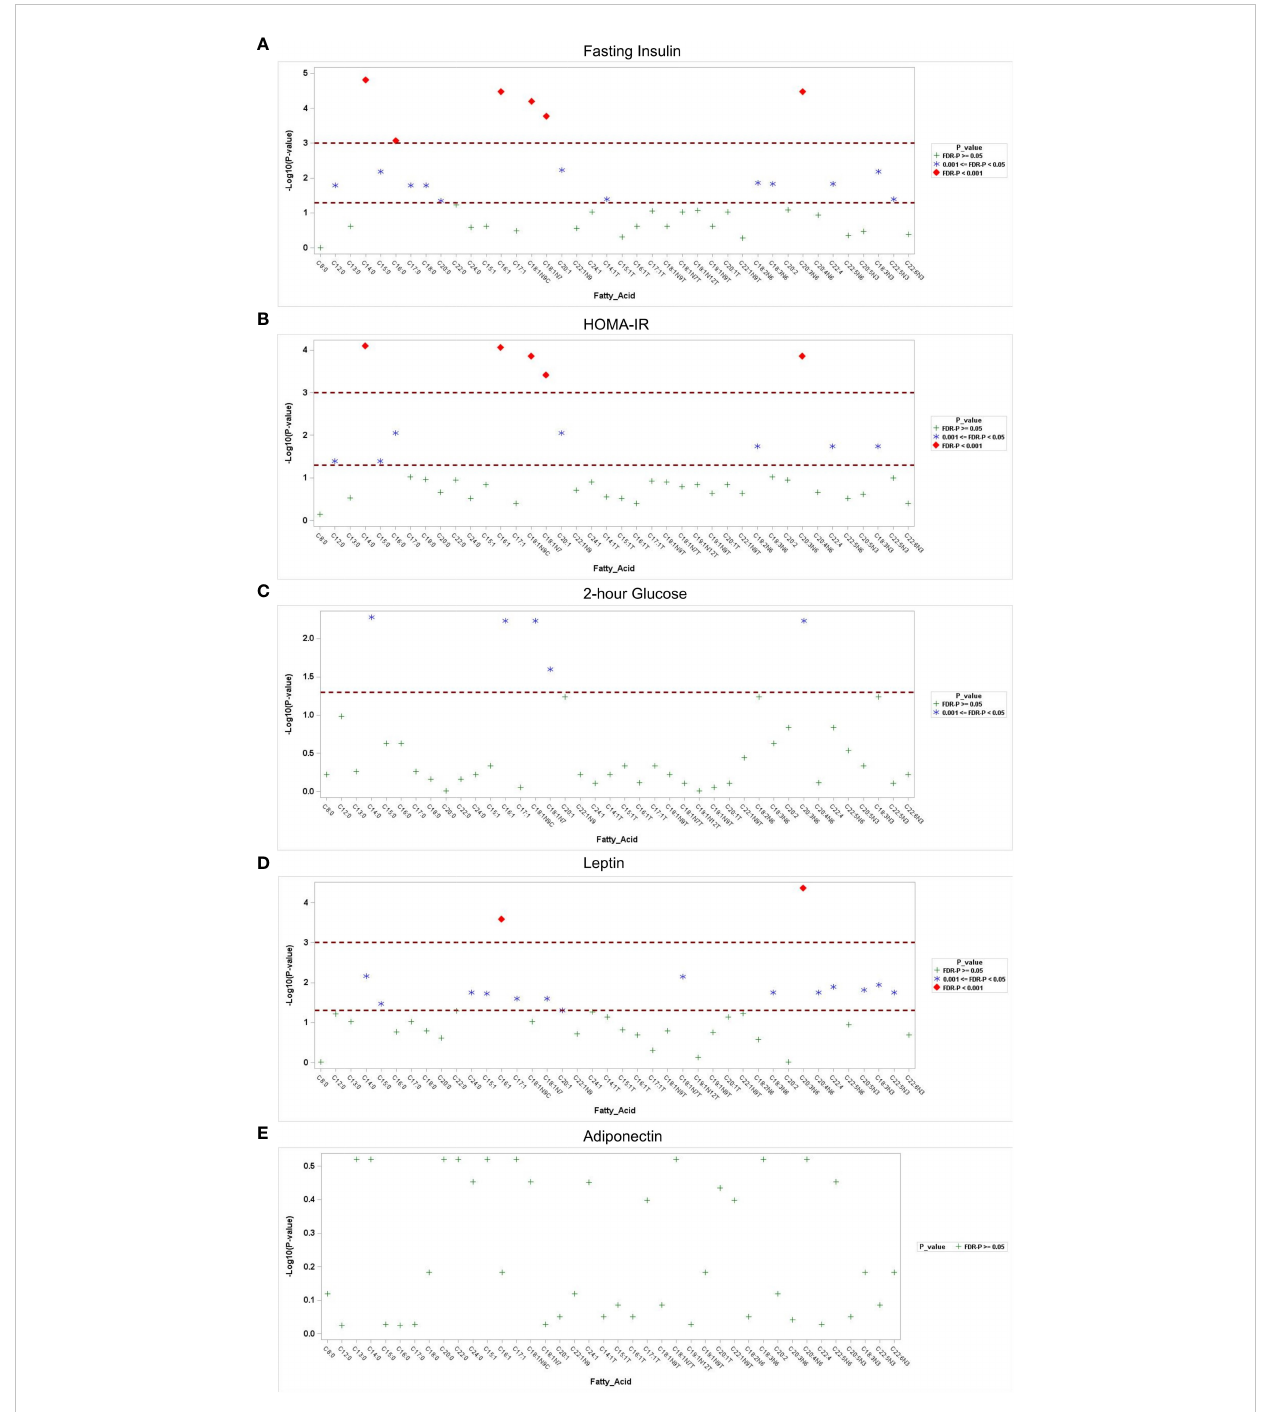
FIGURE 2 Association of fatty acids with metabolic parameters. Manhattan plots of the -log 10 p-value for the fasting insulin (A) , HOMA-IR (B) , 2-hour glucose (C) , serum leptin (D) and adiponectin (E) regressed on log-transformed fatty acids. Each y-axis represents the-log model, and each x-axis represents the serum fatty acid. Serumfatty acids with Benjamini – Hochberg false discovery rate-corrected p -values <0.05 and p -values <0.001 are